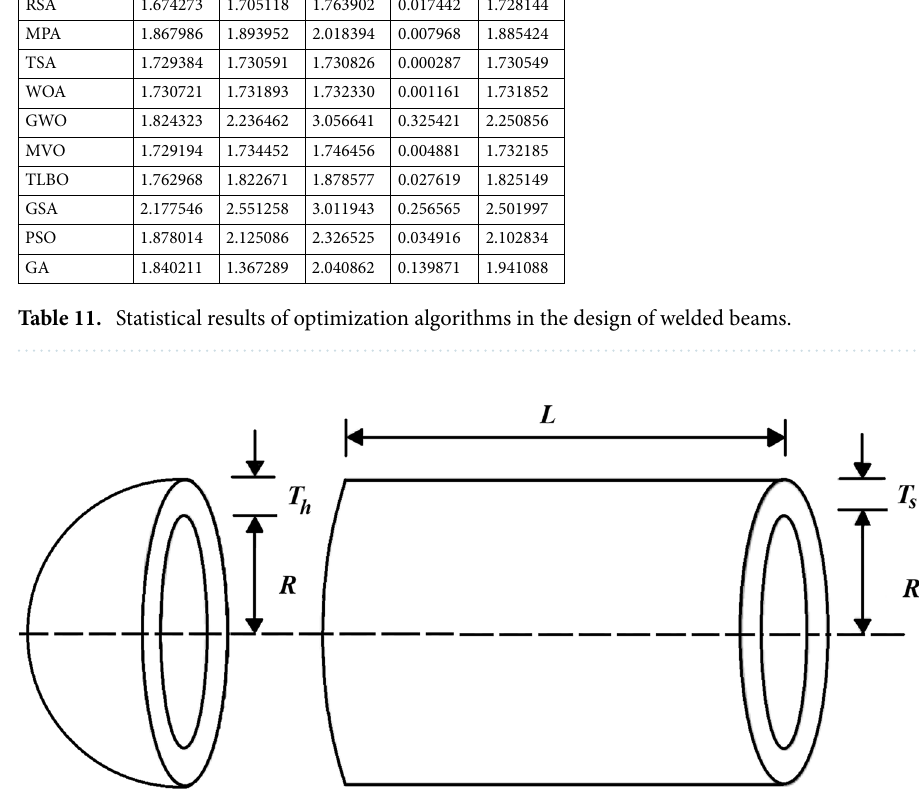
Figure 4. Schematic of pressure vessel